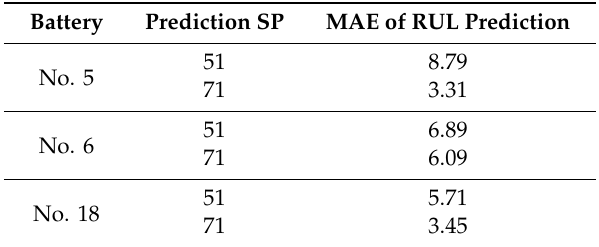
Table 5. The MAE of RUL prediction at di ff erent prediction SP for each battery.